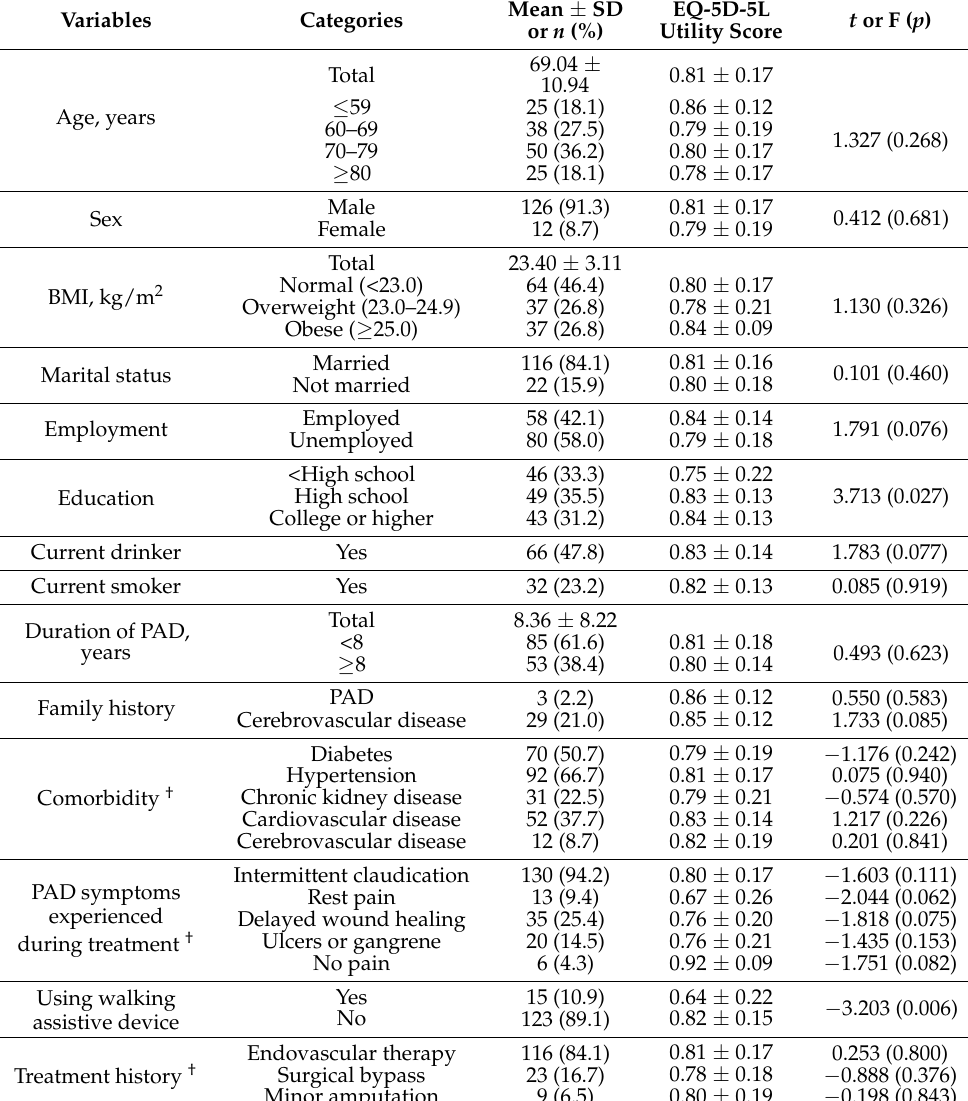
Table 1. Demographic and clinical characteristics ( n =